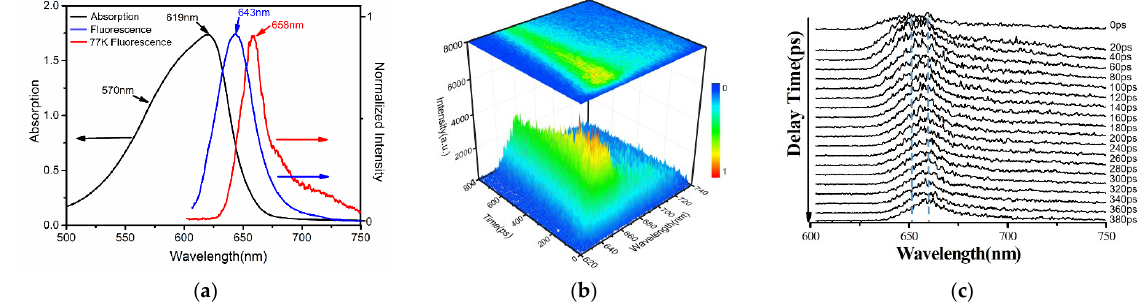
Figure 1. Spectral detection results: ( a ) Steady-State Spectroscopy. The black line represents the absorption spectra of C − PC at room temperature. The Blue line represents the fluorescence spectra of C − PC at room temperature. The Red line represents the fluorescence spectra of C − PC at 77 K; ( b ) Time-resolved fluorescence spectra of C − PC hexamer at 77 K with excitation at 570 nm. ( c ) Normalized time-resolved fluorescence spectra of C − PC at 77 K. Each spectrum is shown after normalization to the maximum intensity. The numbers in the figure show the time in picoseconds after excitation.